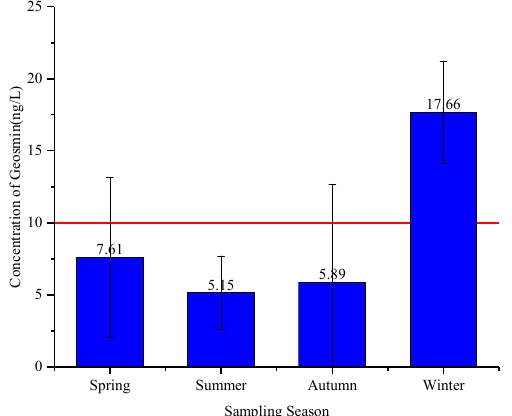
Figure 1. Seasonal variation in geosmin concentration in raw water of Huangpu River. The red line represented the limitation of drinking water in China.